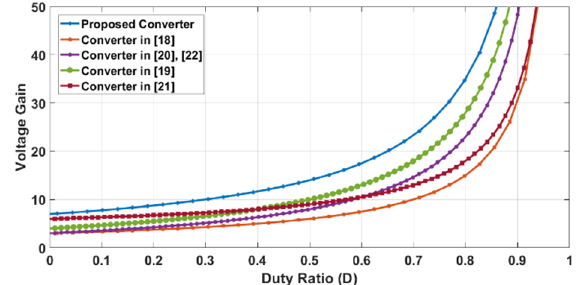
Figure 6. The voltage gain comparison of various converters.